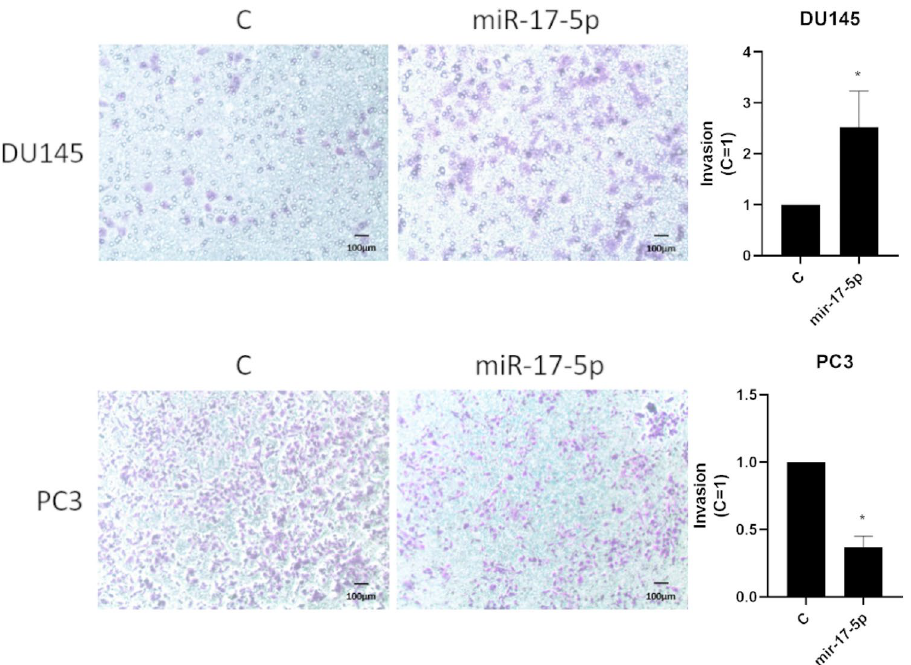
of three experiments for both DU145 and PC3 cell lines. Full results for all experiments are presented in Supplementary Table